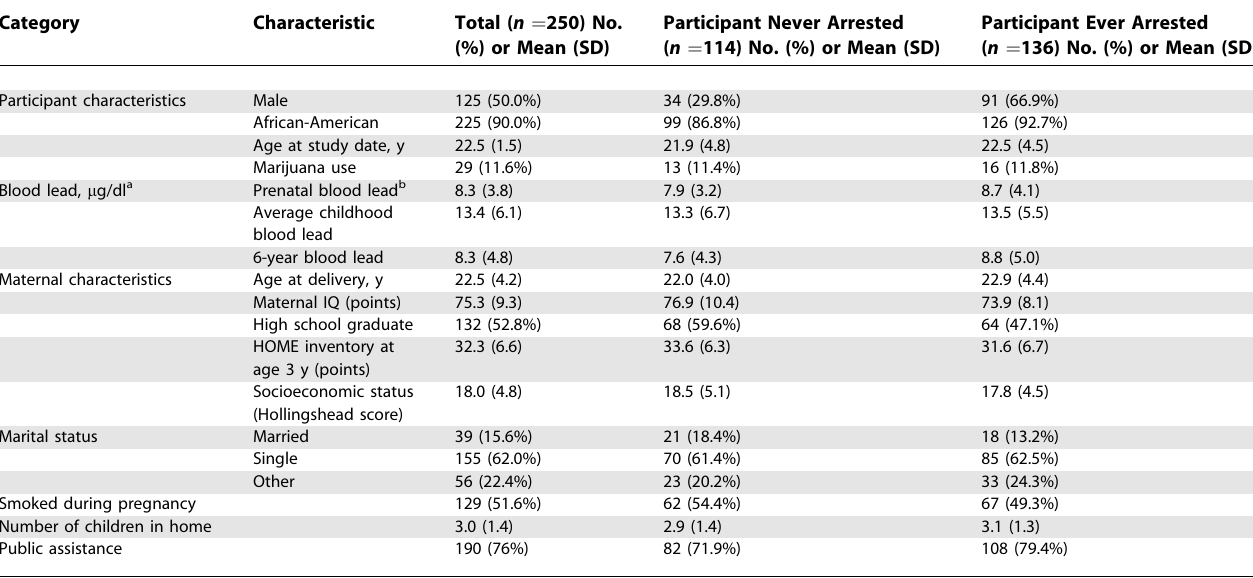
Table 1. Characteristics of the Participants and of their Mothers in the Cincinnati Lead Study ( n ¼ 250) Category Characteristic